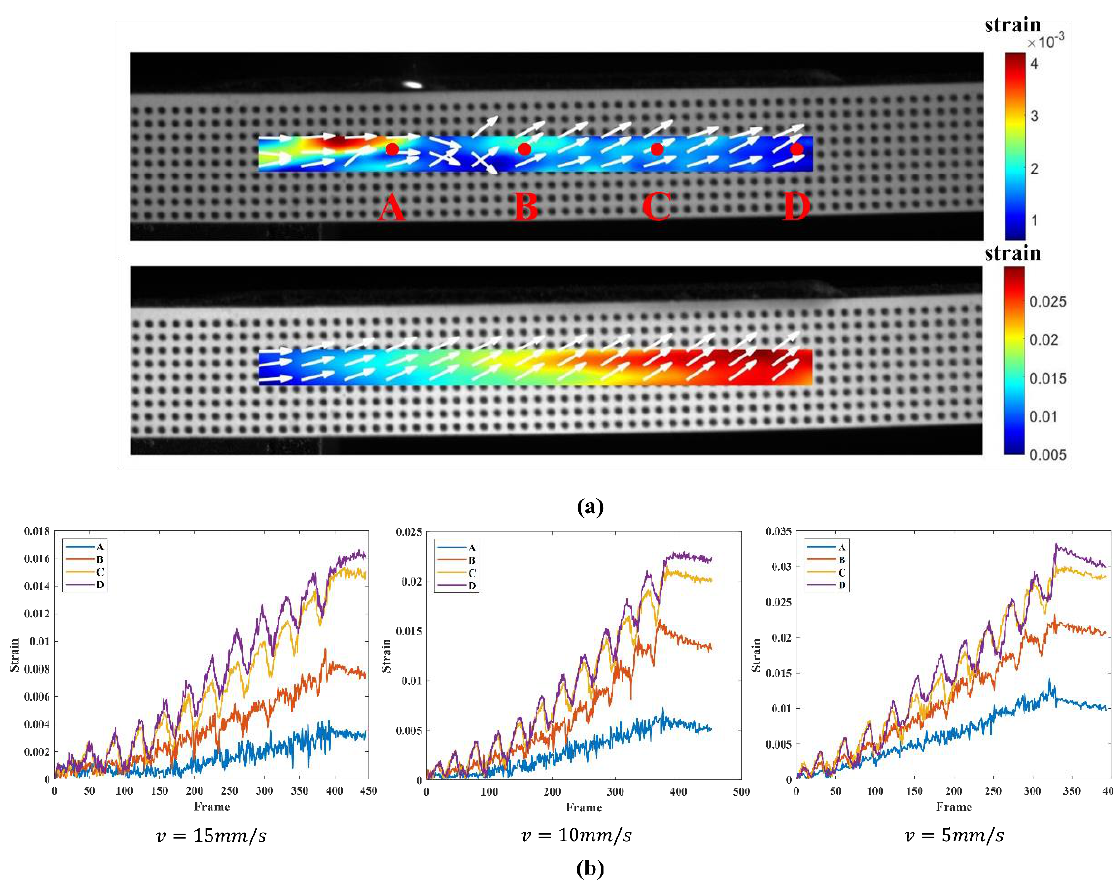
Figure 16. ( a ) The equivalent strain field at the beginning and the end of printing at 10 mm/s, and ( b ) the time-dependent curve of the equivalent strain at four points A, B, C and D.